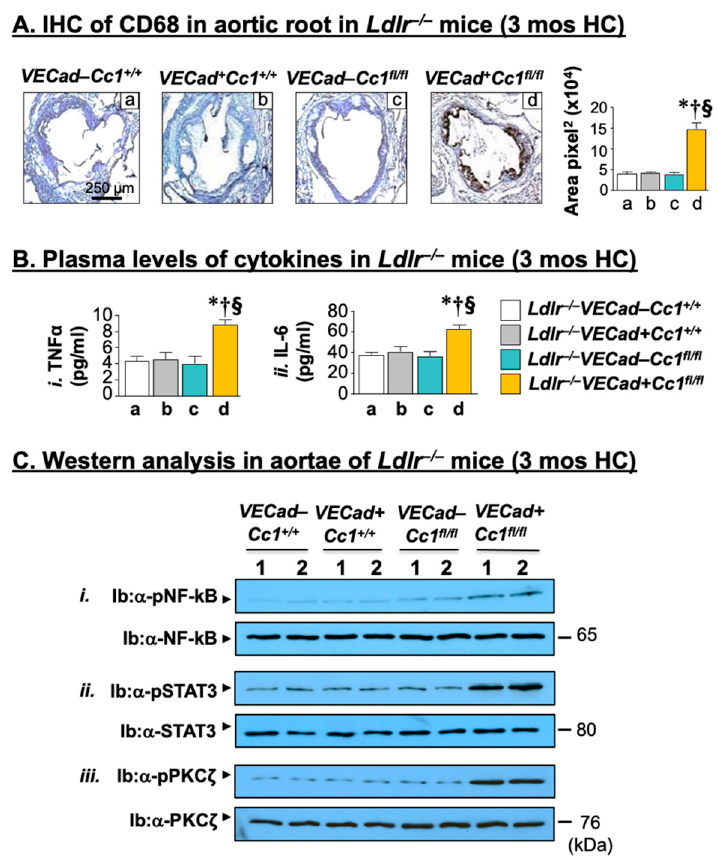
Figure 2. Vascular inflammation. Littermate male mice (n ≥ 5/genotype) were fed HC for 3 months before ( A ) IHC analysis of CD68 in aortic roots was performed. Positive stained areas (brown) calcu- lated as area pixel 2 using Image J were expressed as mean ± SEM and represented in the accompany- ing graph [ Ldlr − / − VECad–Cc1 +/+ (a, white bar), Ldlr − / − VECad+Cc1 +/+ (b, grey bar), Ldlr − / − VECad– Cc1 fl/fl (c, teal bar), and Ldlr − / − VECad+Cc1 fl/ fl (d, yellow bar)]. * p < 0.05 vs. Ldlr − / − VECad–Cc1 +/+ ; † p < 0.05 vs. Ldlr − / − VECad+Cc1 +/+ ; and § p < 0.05 vs. Ldlr − / − VECad–Cc1 fl/fl . ( B ) Retro-orbital venous blood was drawn from overnight fasted mice to assess plasma levels of (i) TNF α and (ii) IL-6. The graph represents values as mean ± SEM [ Ldlr − / − VECad–Cc1 +/+ (a, white bar), Ldlr − / − VECad+Cc1 +/+ (b, grey bar), Ldlr − / − VECad–Cc1 fl/fl (c, teal bar), and Ldlr − / − VECad+Cc1 fl/fl (d, yellow bar)]. * p < 0.05 vs. Ldlr − / − VECad–Cc1 +/+ ; † p < 0.05 vs. Ldlr − / − VECad+Cc1 +/+ ; and § p < 0.05 vs. Ldlr − / − VECad–Cc1 fl/fl . ( C ) Western blot analysis was performed on aorta lysates by immunoblotting (Ib) with antibodies ( α -) against phosphorylated (i) α -pNF- κ B, (ii) α -pSTAT3, and (iii) α -pPKC ζ and was normalized by immunoprobing parallel gels with antibodies against total NF- κ B, STAT3, and PKC ζ , respectively. Numbers (in kDa) to the right of the gels indicate the apparent molecular mass of the signaling proteins. Gels represent analysis on 2 mice/genotype performed on different sets of mice/protein. The data demonstrate that null deletion of Ceacam1 in endothelial cells caused a cell- autonomous positive effect on NF- κ B and Stat3 activation and their downstream tran- scriptional targets to induce an inflammatory microenvironment in Ldlr − / − VECadCre+Cc1 fl/fl aortae.